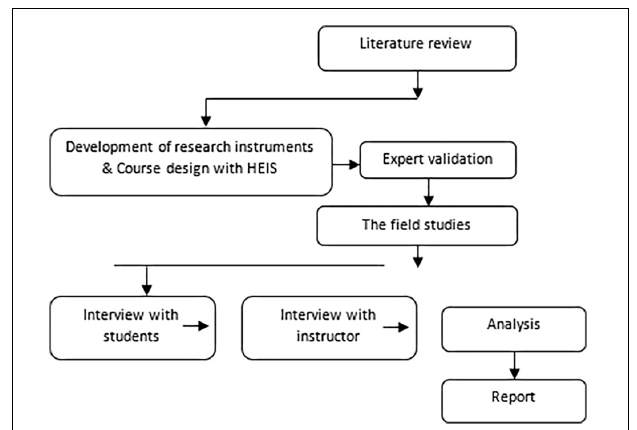
FIGURE 2 | Research